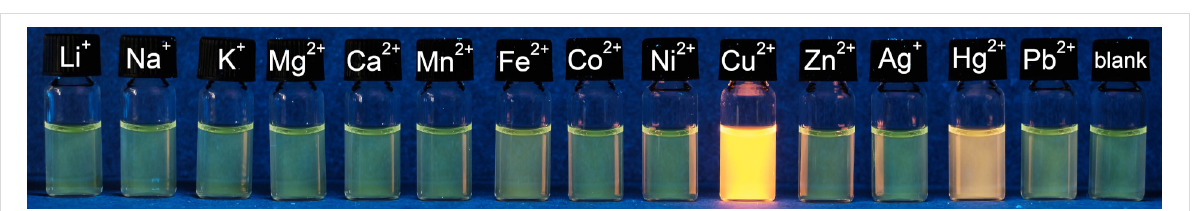
Figure 4: Emission colors of solutions resulting from the addition of metal ions ( c = 50 µM) to derivative 3a ( c = 20 µM in MeCN); t = 1 h; λ ex = 366